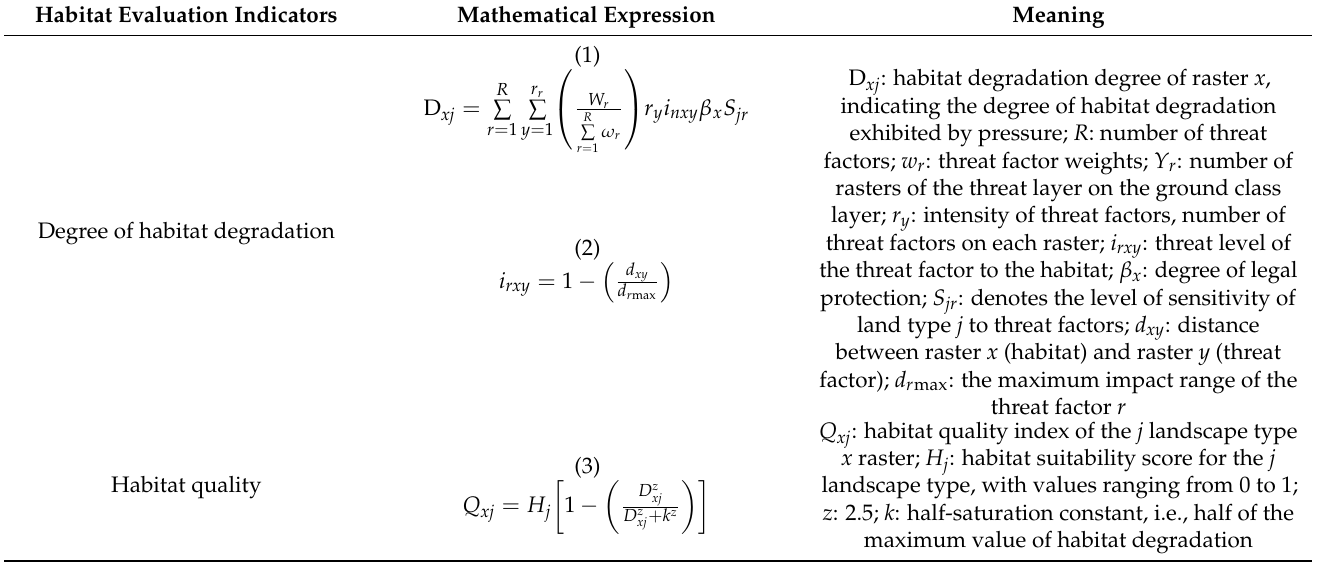
Table 5. Habitat evaluation indices and meaning.